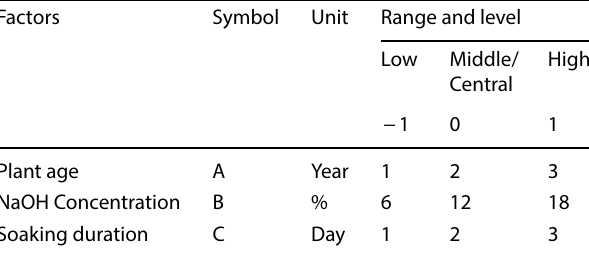
Table 3 Design layout of independent variables and coded values Factors Symbol